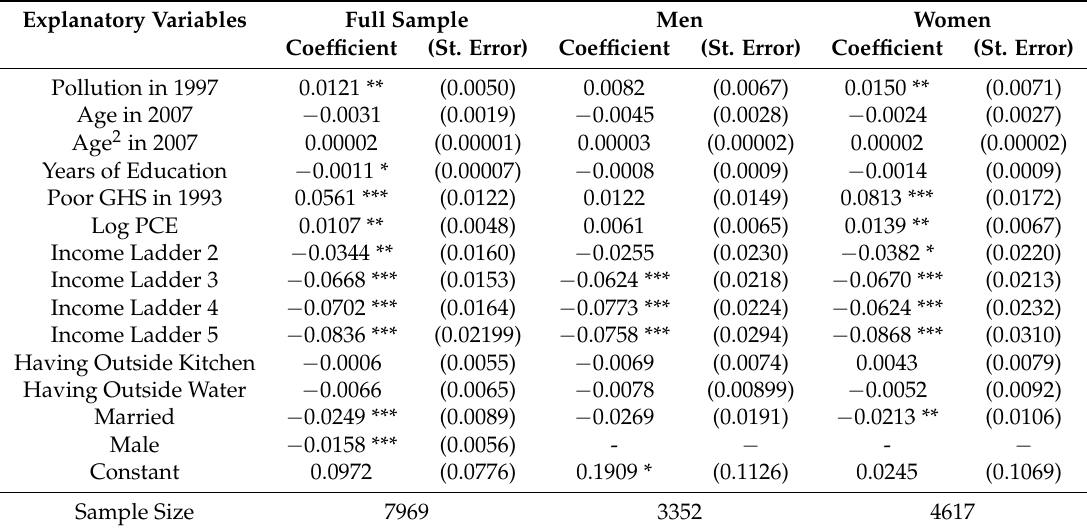
Table 3. The Effects of Pollution on Clinical Depression (OLS Regression